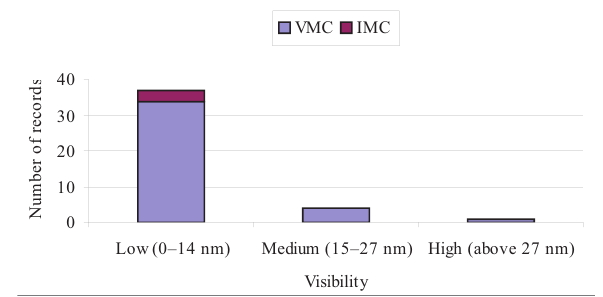
Figure 8. Records distribution based on visibility Figure 9. Reported vortex-induced roll angle (absolute)